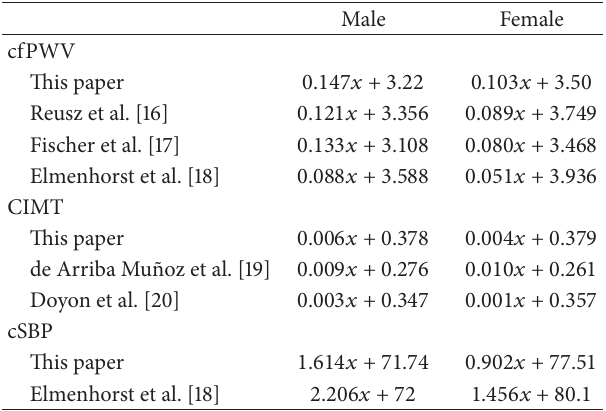
Table 4: Regression models for cfPWV, CIMT, and cSBP (as a function of age) from other